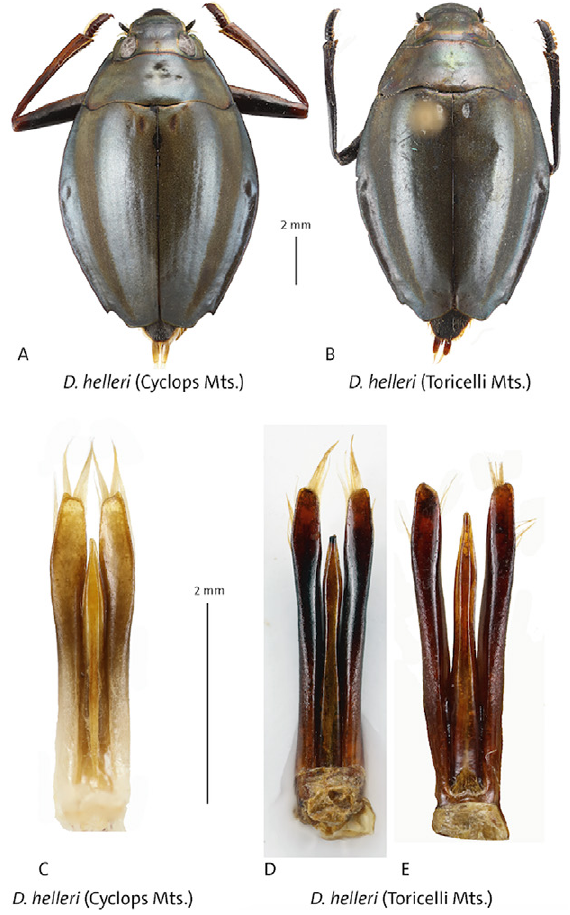
Figure 1. Dineutus helleri . Habitus dorsal. A. Dineutus helleri stue- beri , Kamp Wolker River. B. Dineutus helleri helleri , Torricelli Mts. Median lobe of aedeagus in dorsal view. C. Dineutus helleri stueberi , Kamp Wolker River. D, E. Dineutus helleri helleri , Torricelli Mts.